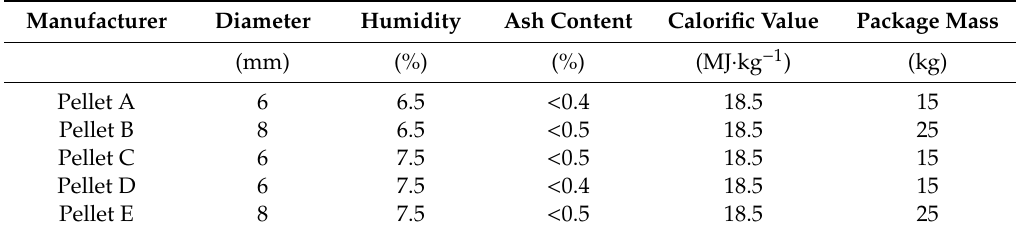
Table 1. Parameters of pellets given by their